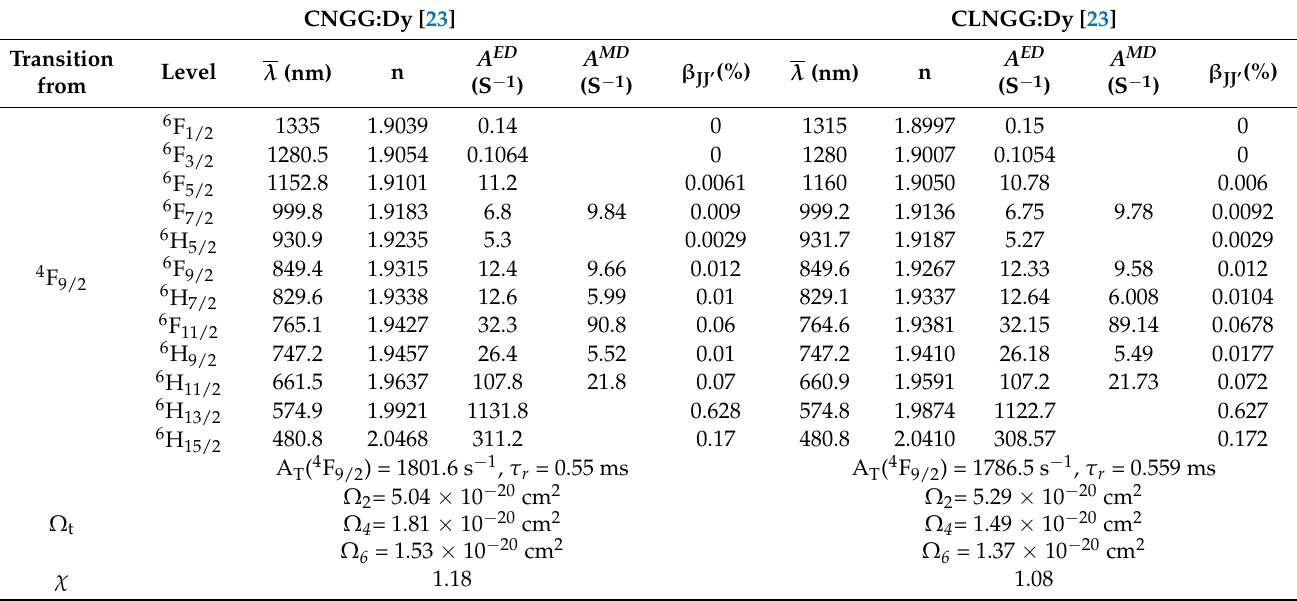
Figure 7. Absorption ( a ) and excitation ( b ) spectra of Dy 3+ ions in CNGG:Dy and CLNGG:Dy crystals. (Reprinted with permission from Ref. [23], copyright 2018, Elsevier). Table 7. Intensity parameters Ω t ( t = 2, 4, 6 ) and other spectroscopic parameters of Dy 3+ ions in CNGG:Dy and CLNGG:Dy crystals. CNGG:Dy [23] CLNGG:Dy [23]